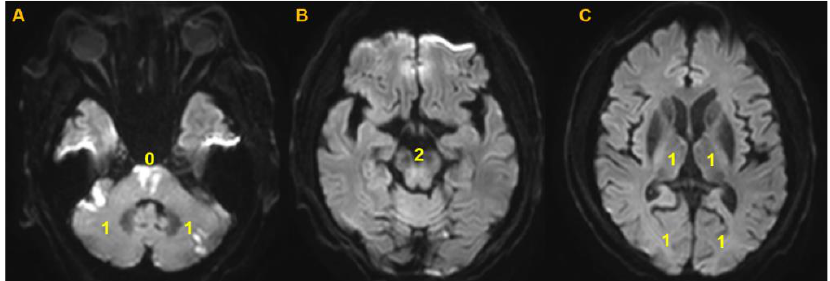
Figure 4. An example of a calculation of PC-ASPECTS from diffusion-weighted image . ( A ) Diffusion restriction is seen at the pontine level. Two points were subtracted at this level. Even though scattered infarction was noted in the bilateral cerebellum, lesions did not exceed 20% of the territories. ( B ) No acute infarction was noted at the midbrain level. ( C ) No acute infarction was noted in the bilateral thalami and PCA territories. This constitutes a total score of 8. PC-ASPECTS, Posterior Circulation-Alberta Stroke Program Early Computed Tomography Score; PCA, posterior cerebral artery.